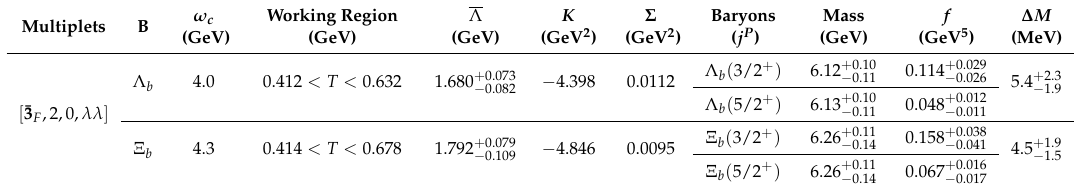
Figure 6. Masses as functions of the Borel mass T , extracted from the bottom baryon doublets: [ Λ b ( ¯3 F ) ,2,0, λλ ] ( upper-left ), [ Ξ b ( ¯3 F ) ,2,0, λλ ] ( upper-right ), [ Λ b ( ¯3 F ) ,1,1, ρλ ] ( middle-left ), [ Ξ ( ¯3 ) ,1,1, ρλ ] ( middle-right ), [ Λ ( ¯3 ) ,3,1, ρλ ] ( lower-left ), and [ Ξ ( ¯3 ) ,3,1, ρλ ] ( lower-right ). F F F b b b The shady bands are obtained by varying T within the Borel window. Table 1. Masses of the D -wave bottom baryons belonging to the SU ( 3 ) flavor ¯3 F representation, obtained using the bottom baryon multiplets [ ¯3 F ,2,0, λλ ] , [ ¯3 F ,1,1, ρλ ] , [ ¯3 F ,2,1, ρλ ] , and [ ¯3 F ,3,1, ρλ ] . There still exists one doublet, the [ ¯3 F ,2,0, ρρ ] doublet, but its sum rule results are a bit strange (the Borel windows become larger as the threshold value ω c decreases), so we do not list it here. In the third and fourth columns we list the two QCD sum rule parameters, the threshold value ω c and the Borel mass T ; in the fifth, sixth, and seventh columns we list the QCD sum rule results, Λ F , j l , s l , ρ / λ at the leading order as well as K F , j and Σ F , j at the O ( 1/ m b ) order; in the ninth, tenth, l , s l , ρ / λ l , s l , ρ / λ and eleventh columns we list the masses m j , P , F , j , decay constants f F , j , and mass l , s l , ρ / λ l , s l , ρρ / λλ / ρλ = m − m splittings ∆ M F , j j l + 1/2, P , F , j l , s l , ρ / λ j l − 1/2, P , F , j l , s l , ρ / λ evaluated within the QCD sum l , s l , ρρ / λλ / ρλ rule